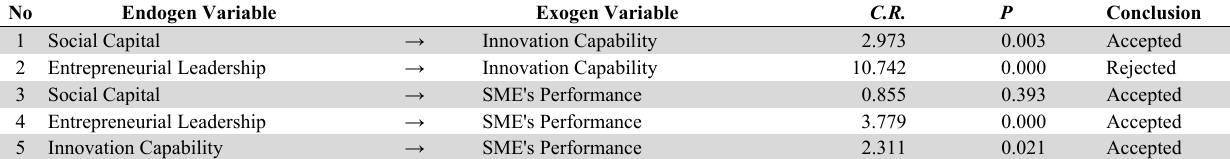
Standardized Regression